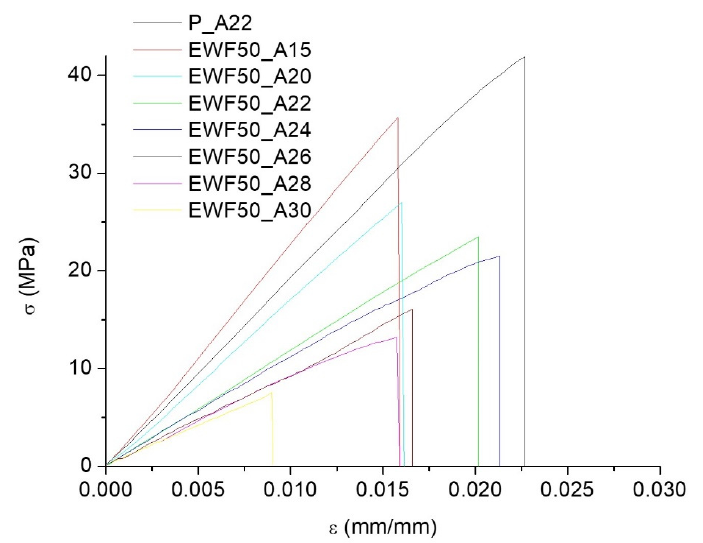
Figure 11. Stress–strain curves from flexural tests of cured blends at different amine contents. Table 4. Flexural properties of cured blends at different amine contents .